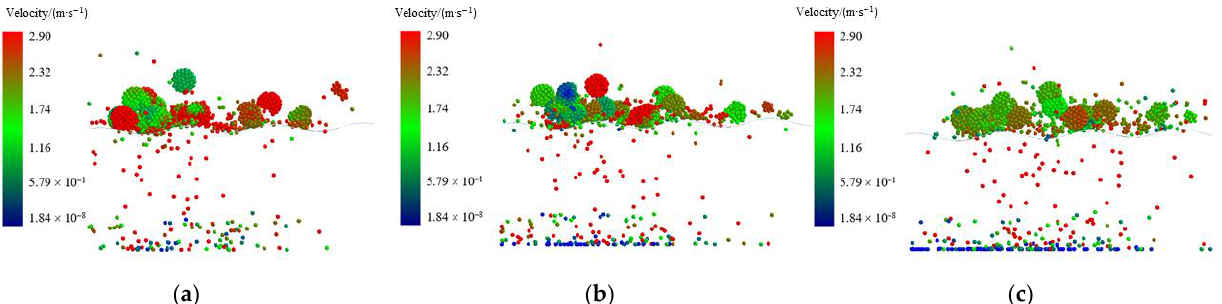
Figure 11. Velocity graph of frass agglomerates at an amplitude of 0.011 m. ( a ) t = 1.8 s. ( b ) t = 2.2 s. ( c ) t = 2.6 s.